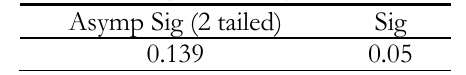
Table 1. One Sample Kolmogorov-Smirnov Test